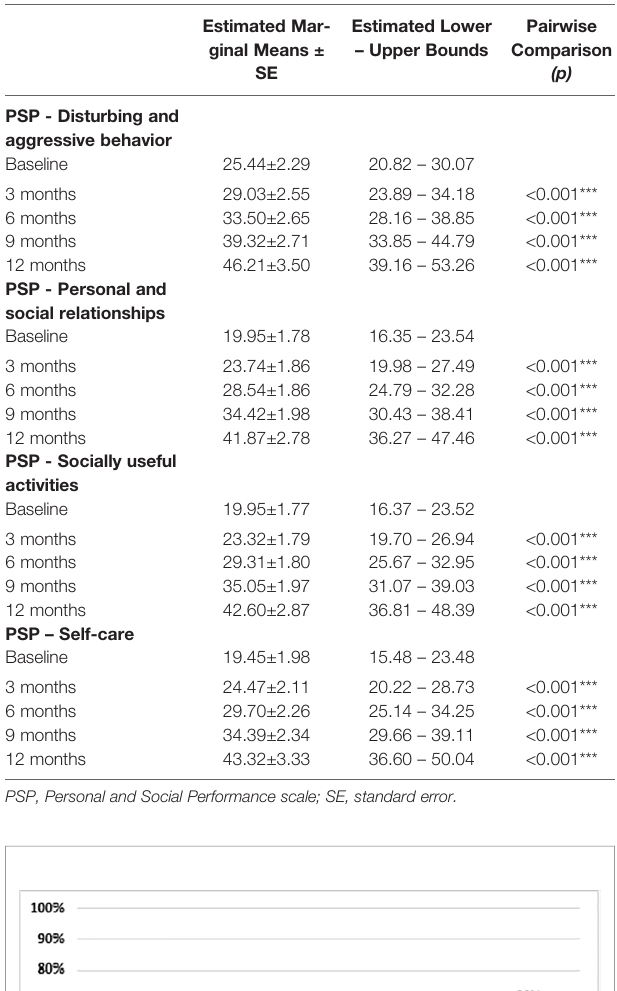
TABLE 5 | PSP within-subjects pairwise comparisons; signi fi cance between successive time-points; * p < 0.05; ** p < 0.01; *** p < 0.001.